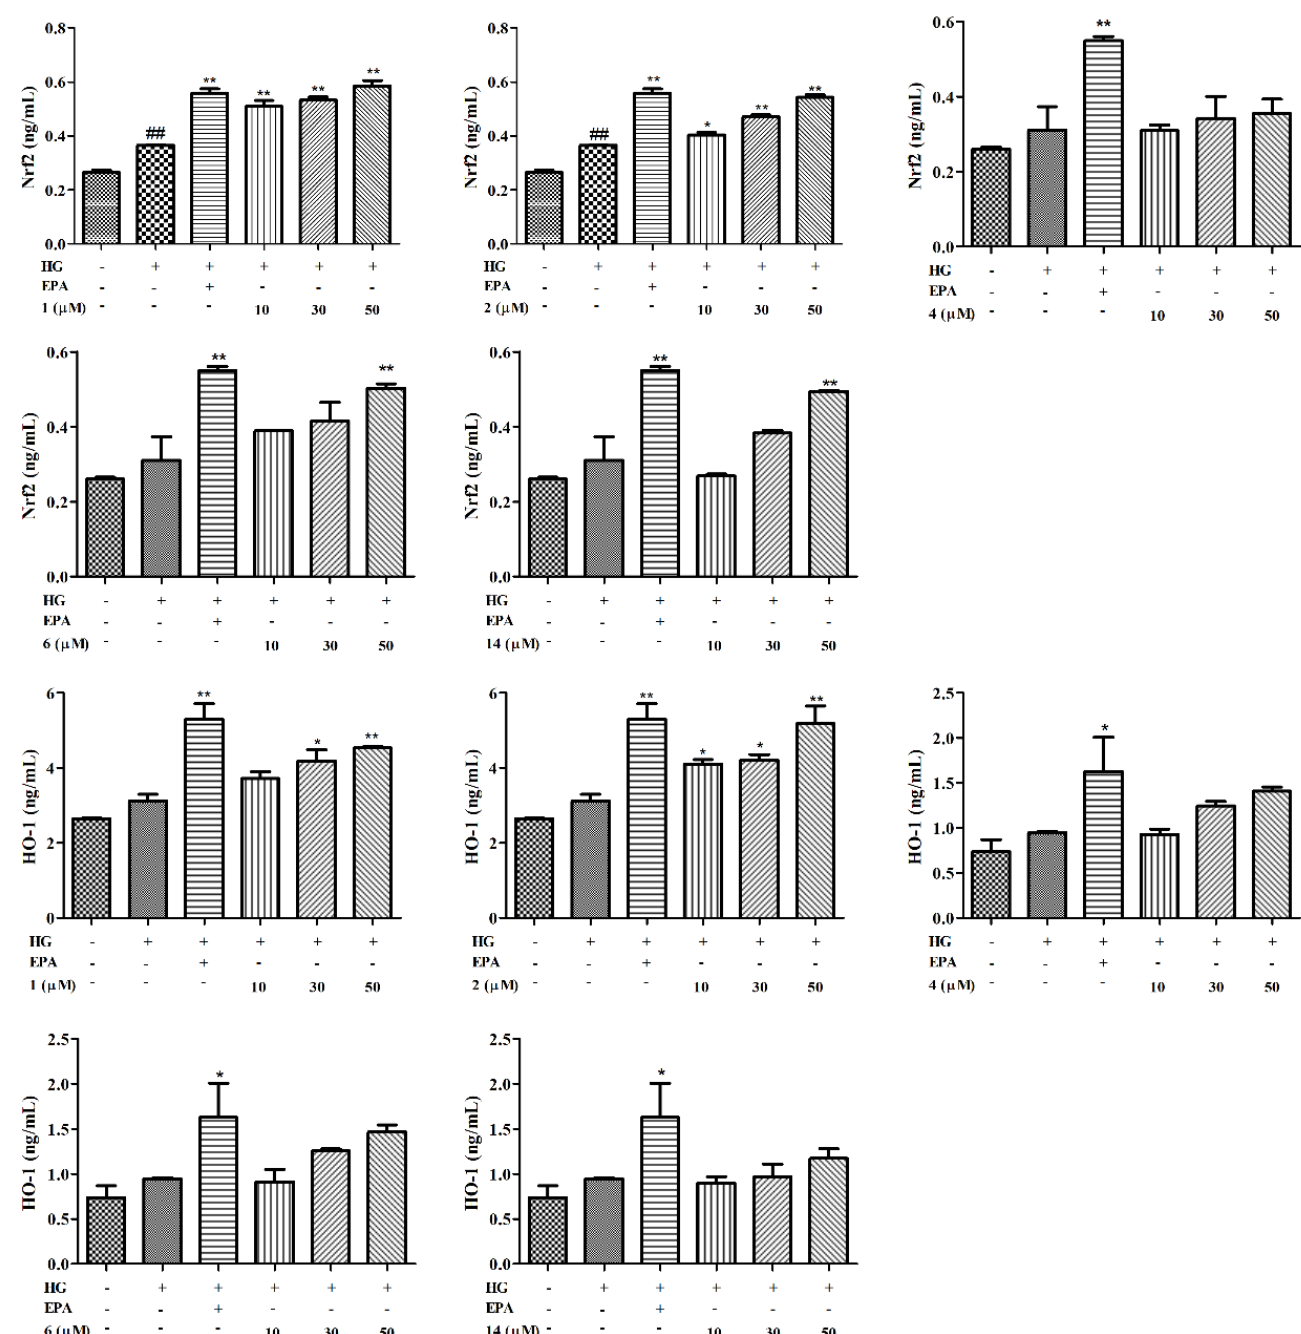
Figure 5. Effects of compounds on oxidative stress in GMCs. The GMCs were treated with or without compounds 1 , 2 , 4 , 6 , 14 at concentrations of 10, 30, and 50 µ M in HG for 48 h. The expressions of Nrf2/HO-1 were analyzed using commercially available Elisa kits. Values are expressed as mean ± SD of three independent experiments, with ## p < 0.05 relative to the NG and * p < 0.05 or ** p < 0.01 relative to the HG